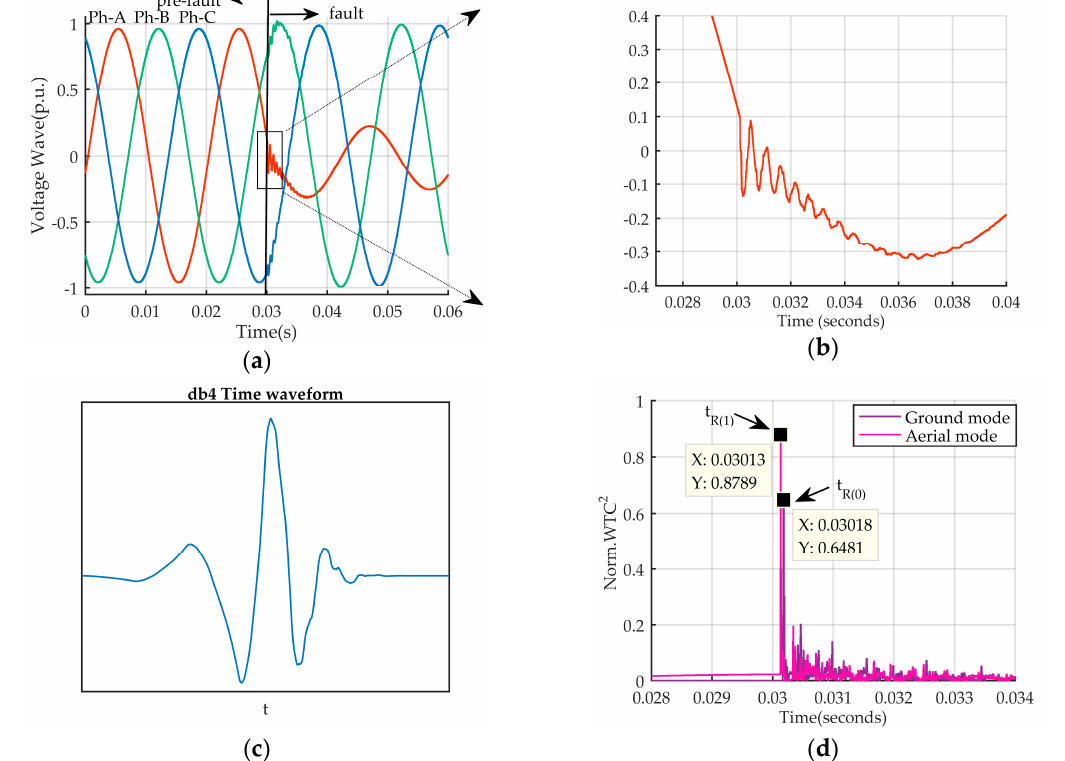
Figure 9. A-phase-to-ground (AG) fault in 265 km from terminal L. ( a ) Three-phase voltage measured in terminal R before and during the fault; ( b ) The enlarged view of the fault-induced distortion waveform; ( c ) Daubechies-4 (db-4) mother wavelet; ( d ) The results of normalized WTC 2 .